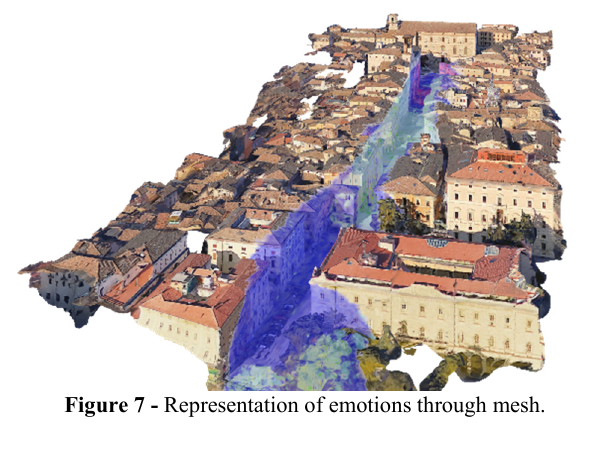
Figure 7 - Representation of emotions through